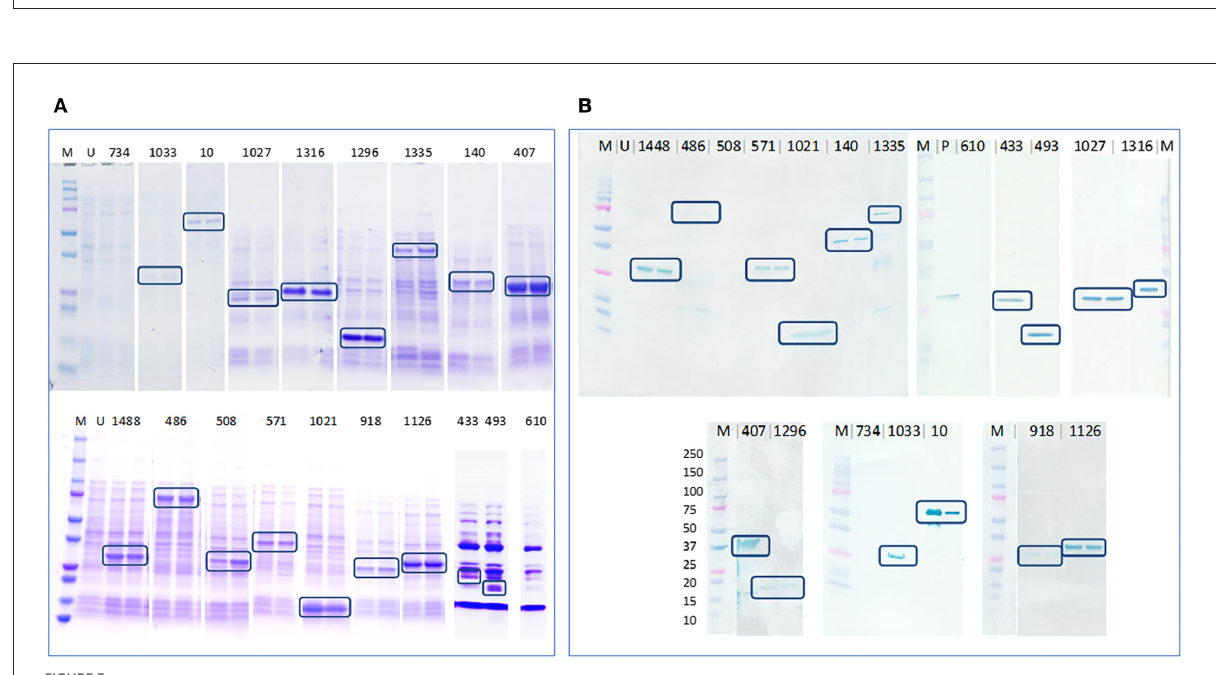
FIGURE3 Determination of protein expression in E. coli cell lysates by Coomassie staining and anti-his western blotting. (A) Coomassie stained gel containing expressed E. coli cell lysates that confirmed the expression of 17 out of 19 proteins, highlighted in blue boxes and (B) PVDF membrane blotted with expressed E. coli cell lysates probed with anti-his antibody that confirmed the expression of 16 out of 19 proteins, highlighted in blue boxes. M–Precision plus protein ladder (Bio-Rad), U–uninduced E. coli BL21 (DE3) cell lysate, P–an unrelated his-tagged protein used as a positive